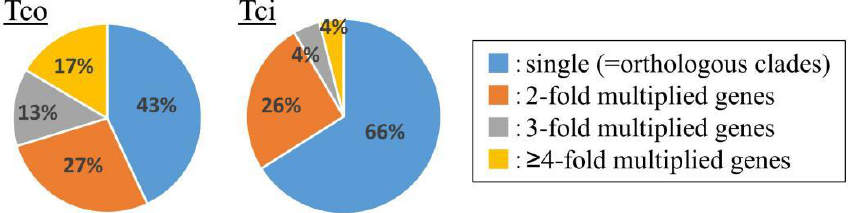
Figure 5. Multiplication analysis of genes encoding proteins with the superfamily “cytochrome P450” (IPR036396) domain in the T. coccineum and T. cinerariifolium genomes. Tco: T. coccineum ; Tci: T. cinerariifolium .